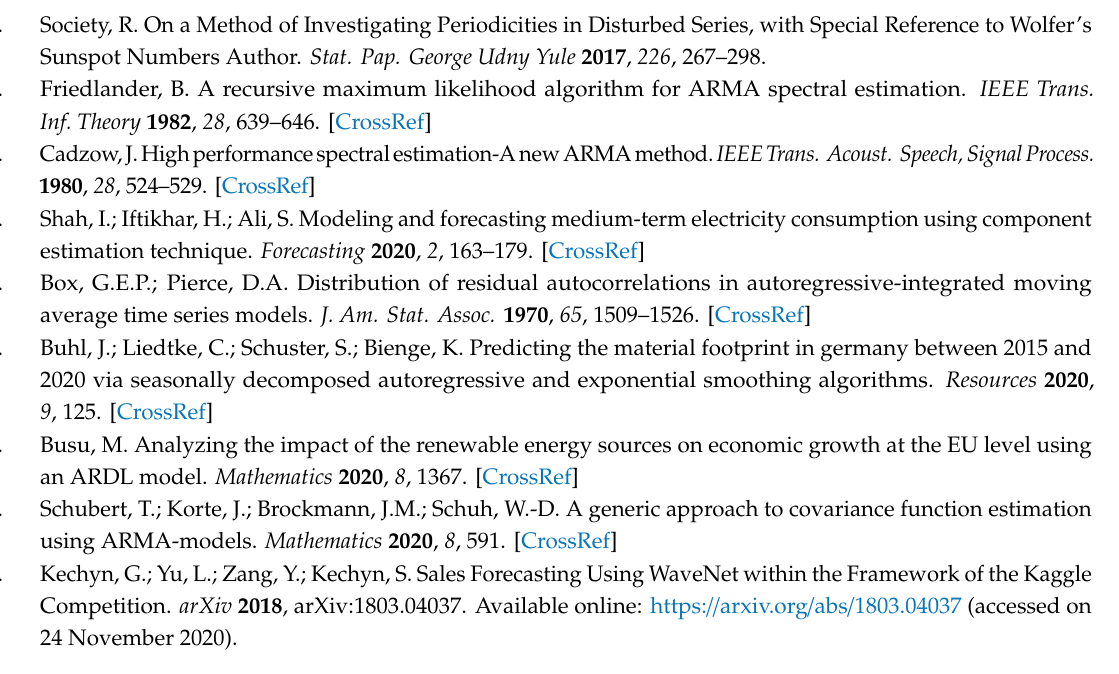
Figure A6. View of the Data Prediction Module. On the left, the “Predict Runner” shows allows us to choose some hyperparameters to set up the prediction model, such as the periods of the forecast, the prediction model, and the validation method. On the right, the software can visualize the prediction